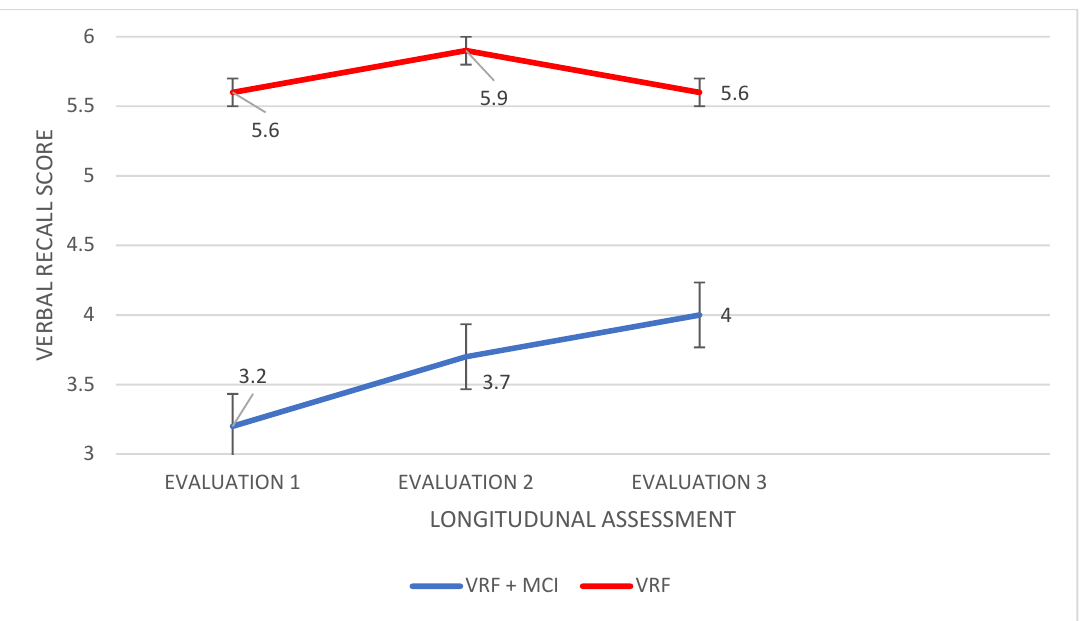
Figure 6. Performance of people with VRF and people with VRF + MCI in Delayed Verbal Recall (long ‐ term memory).